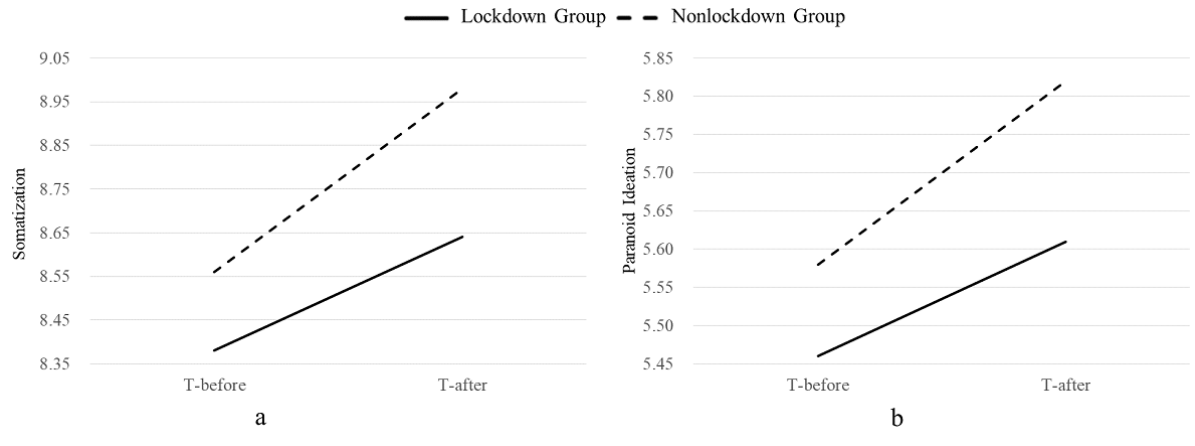
Figure 1. Interactions of area and time on (a) somatization and (b) paranoid ideation across China. T-after: the period after the residential lockdown; T-before: the period before the residential lockdown.